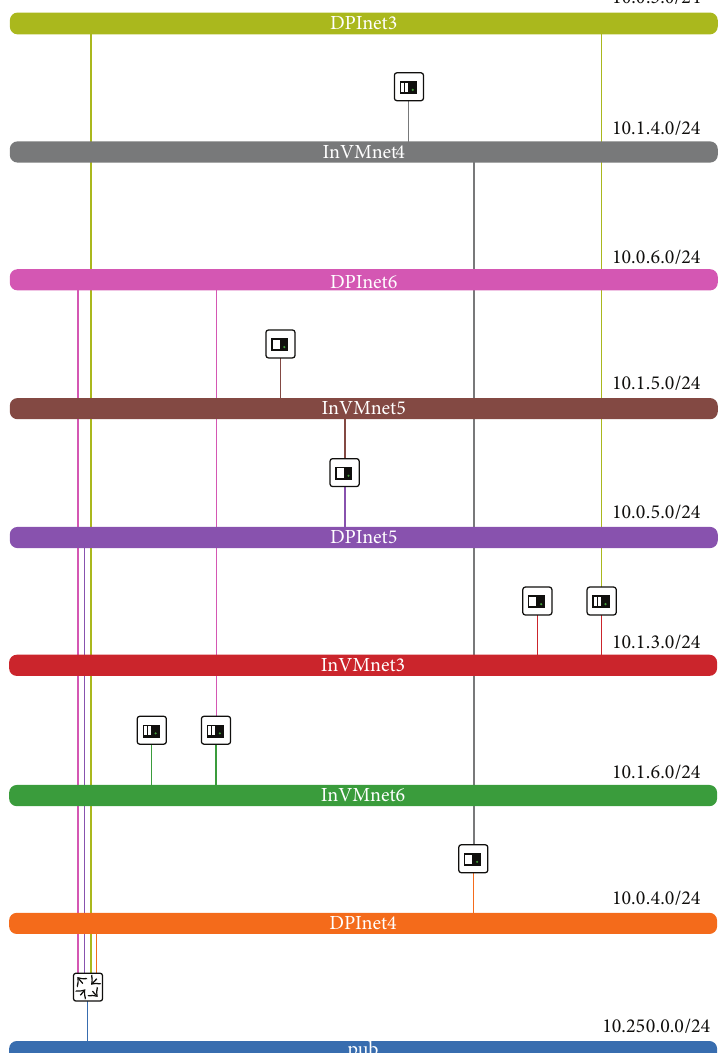
Figure 6: The OpenStack dashboard shows the tenants virtual networks (slices). Each slice includes VM connected to an internal network (InVMnet 𝑖 ) and a second VM performing DPI and packet forwarding between InVMnet 𝑖 and DPInet 𝑖 . Connectivity with the public Internet is provided for all by the virtual router in the bottom-left